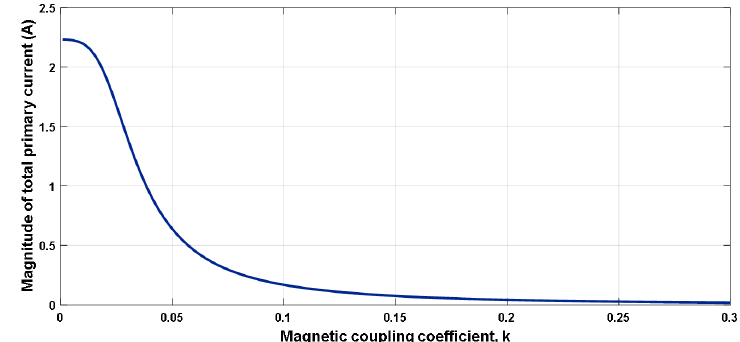
Figure 10. Relationship of total primary current and magnetic coupling coefficient.